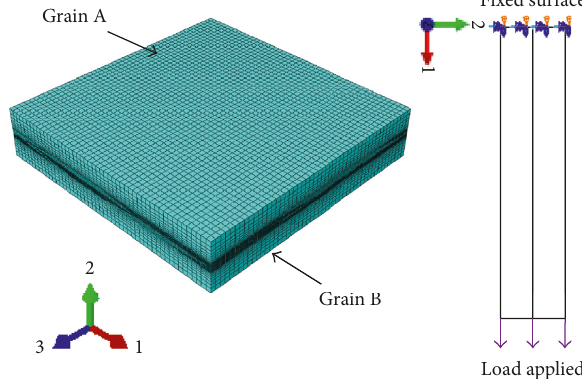
Figure 2: Type-II grain boundary: GB parallel to the tensile